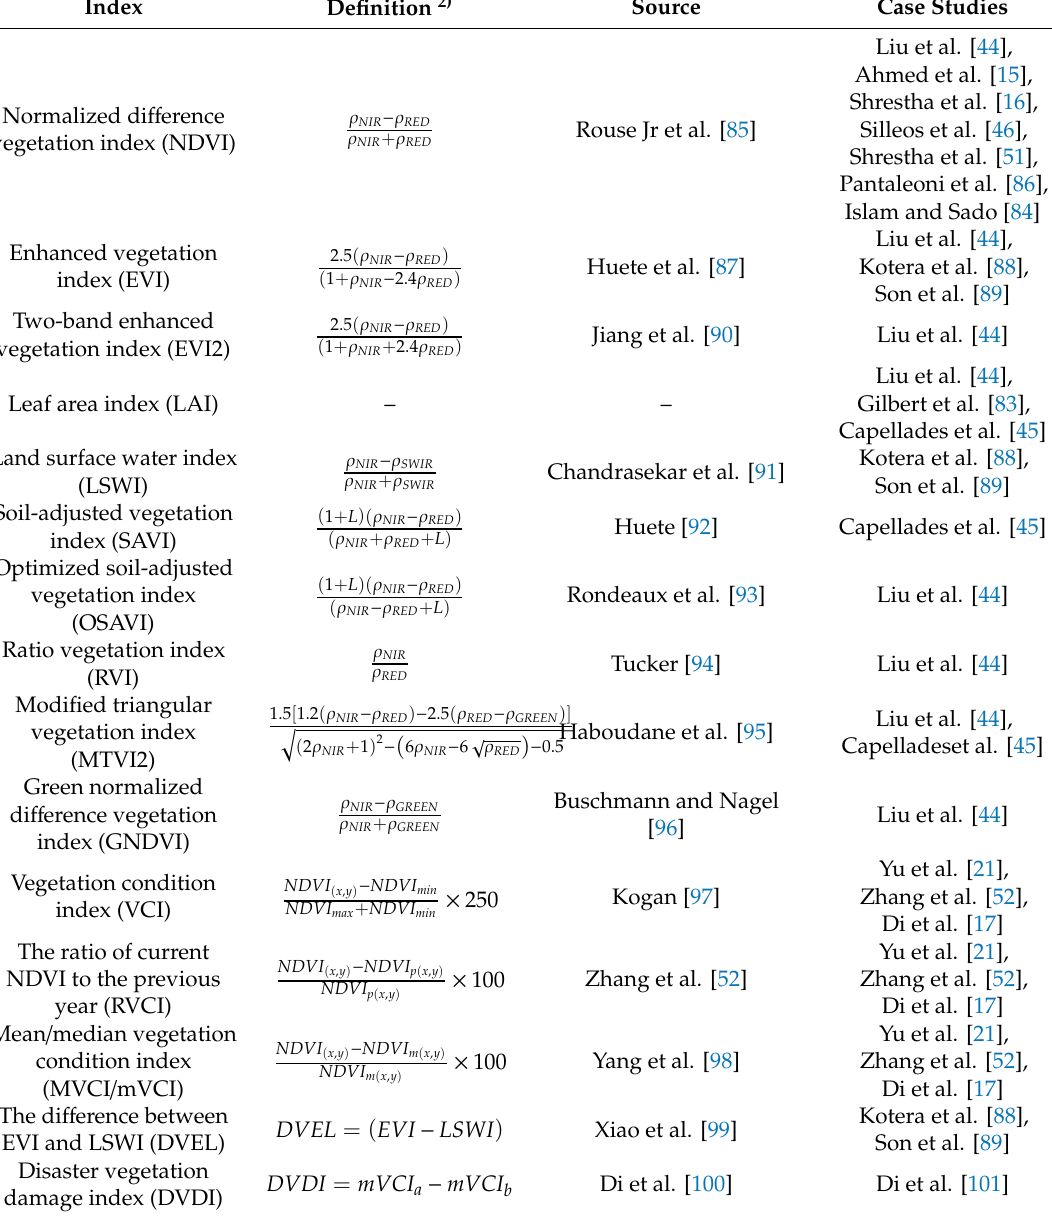
Table 2. Indices used in crop-condition-based flood loss